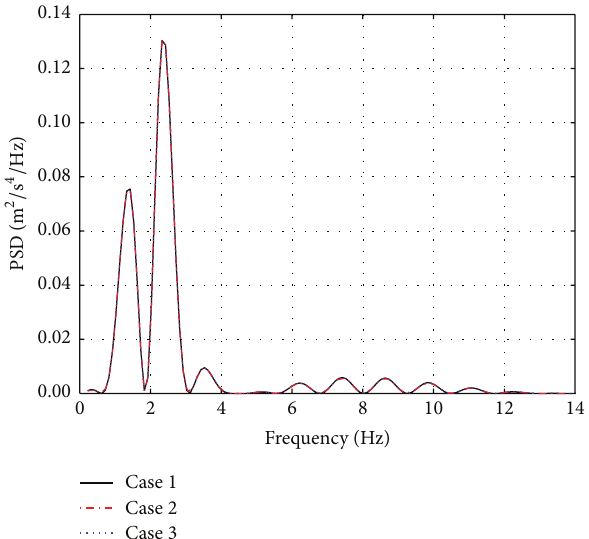
Figure 9: Power spectral density (PSD) of the vertical random vibration acceleration of a vehicle wheel due to the linear secant stiffness, the nonlinear frequency-dependent stiffness, and the non- linear amplitude- and frequency-dependent stiffness of rail pads.